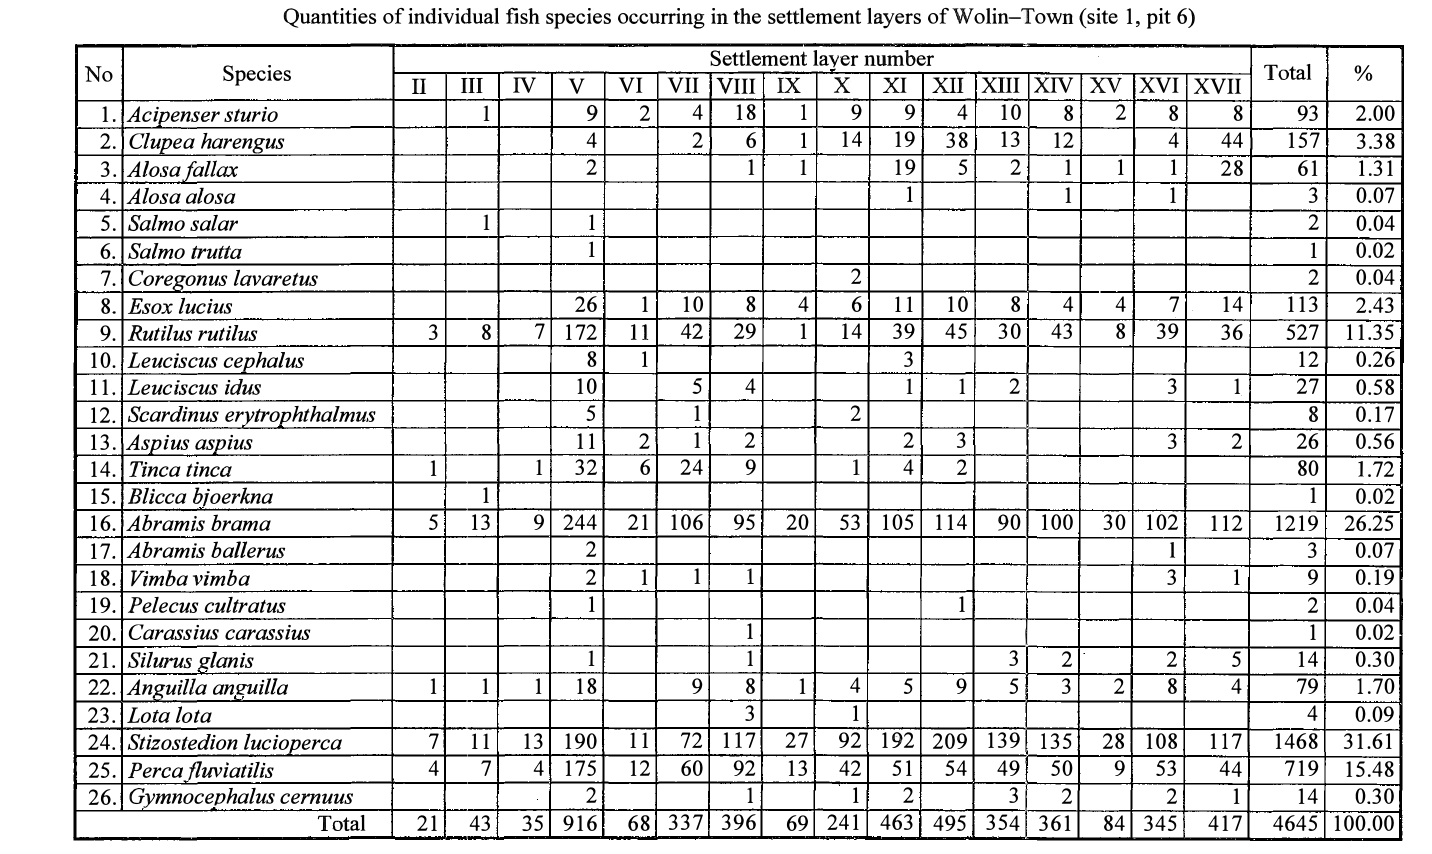
Quantities of individual fish species occurring in the settlement layers of Wolin-Town ( site 1, pit